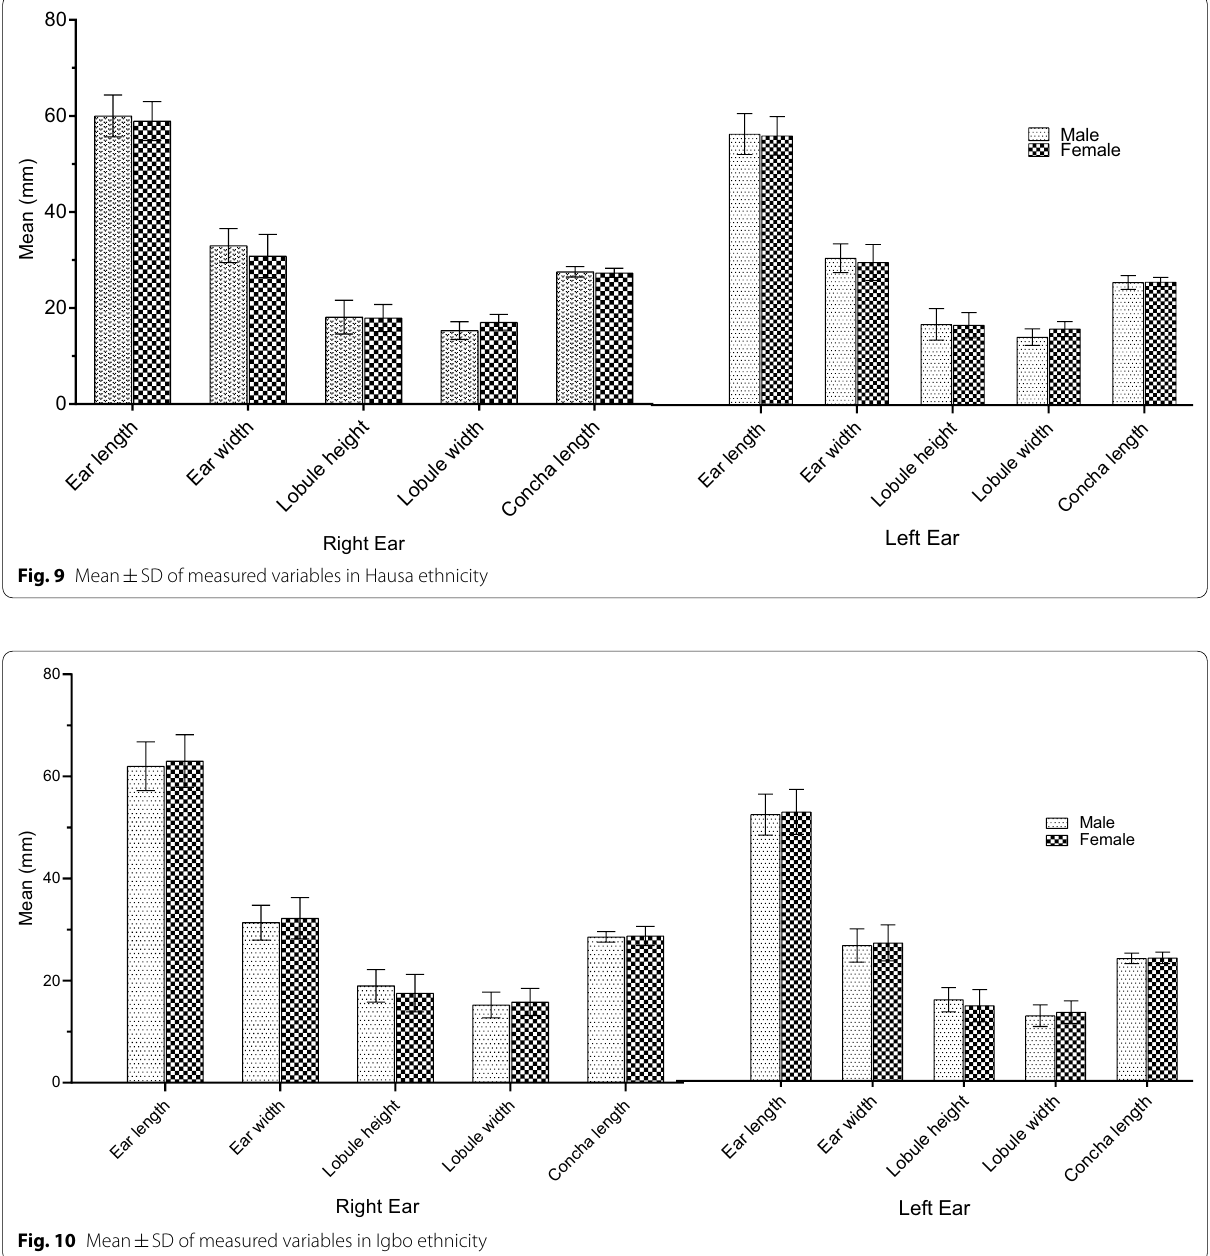
Fig. 10 Mean SD of measured variables in Igbo ±